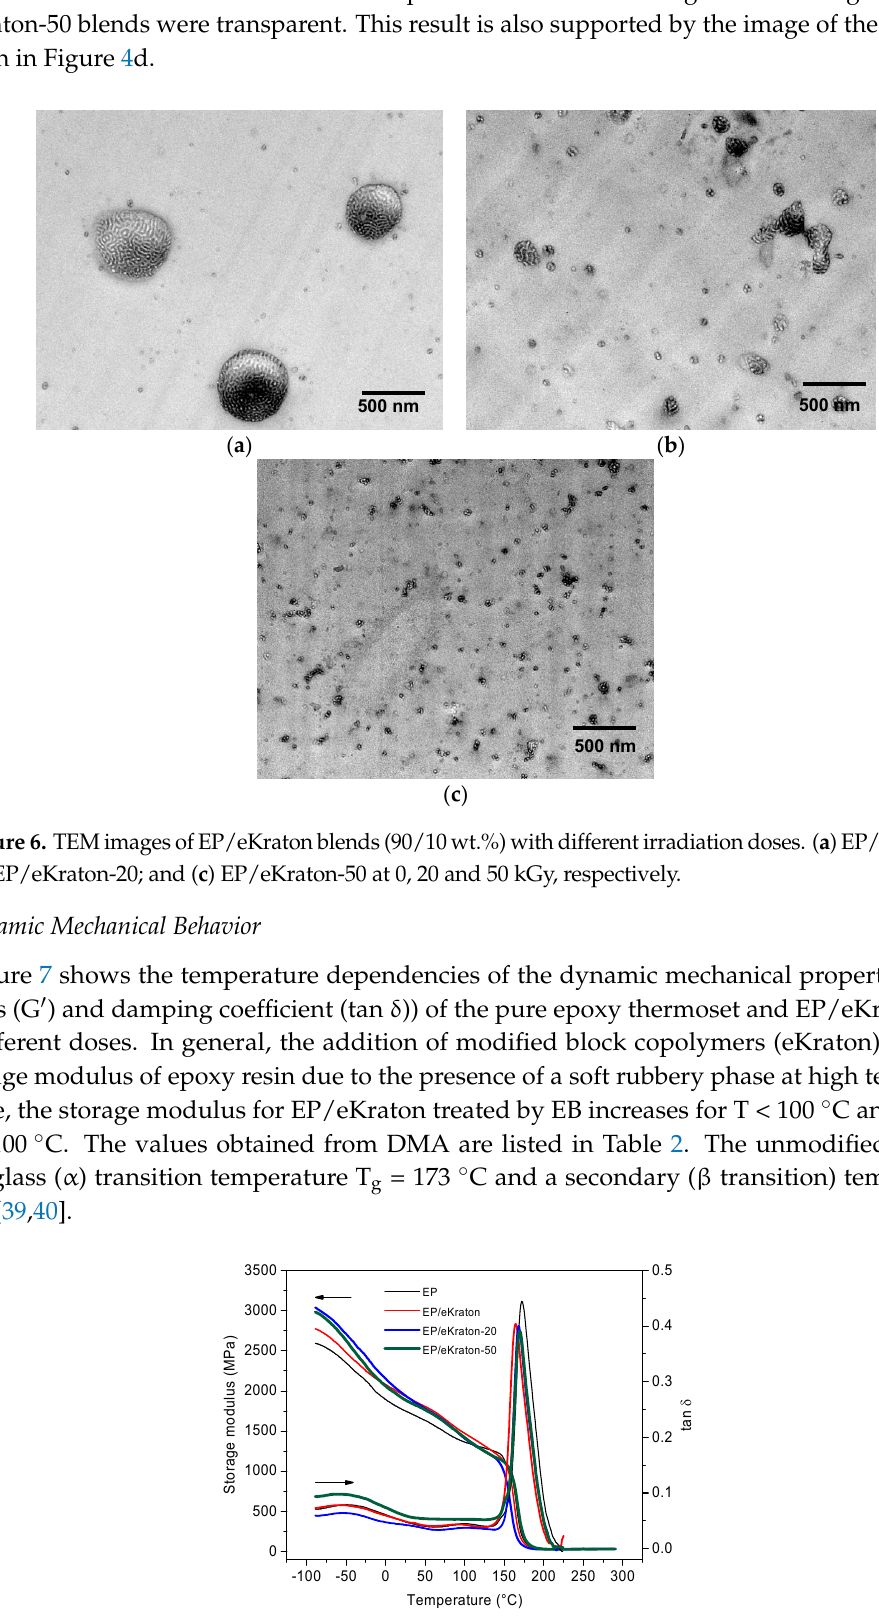
Figure 7. Storage modulus and mechanical loss factor as a function of temperature.